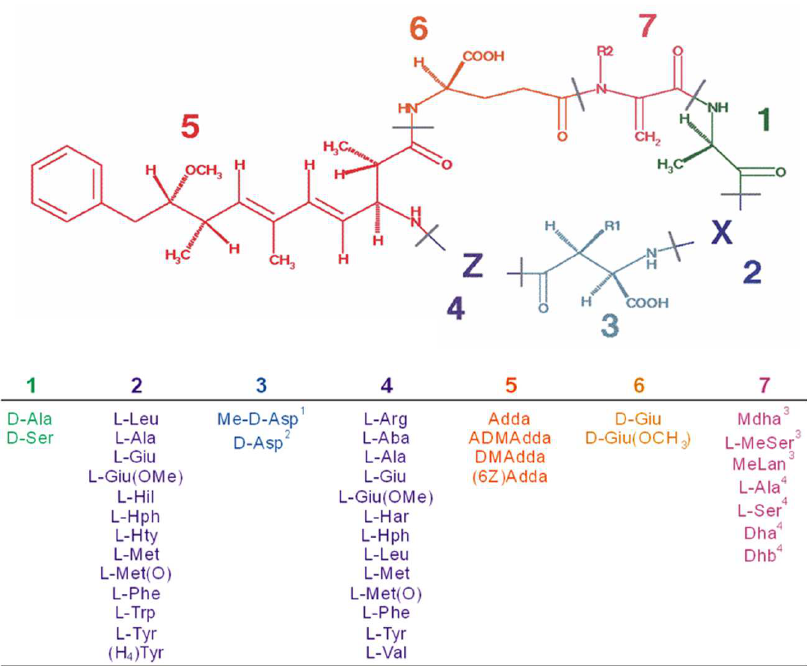
Figure 1. Microcystin chemical structure generalized as cyclo-D-Ala 1 -X 2 -D-MeAsp 3 -Z 4 -Adda 5 -D- Glu 6 -Mdha 7 , where X and Z denote the highly variable L-amino acids present at the second and fourth positions, with possible different combinations of seven amino acids that can produce different microcystin variants (modified from Butler et al. [13]).